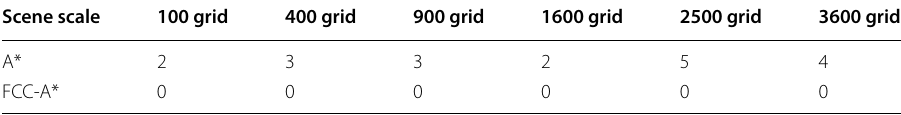
Table 4 Comparison of collision times between two algorithms (unit: times) Scene